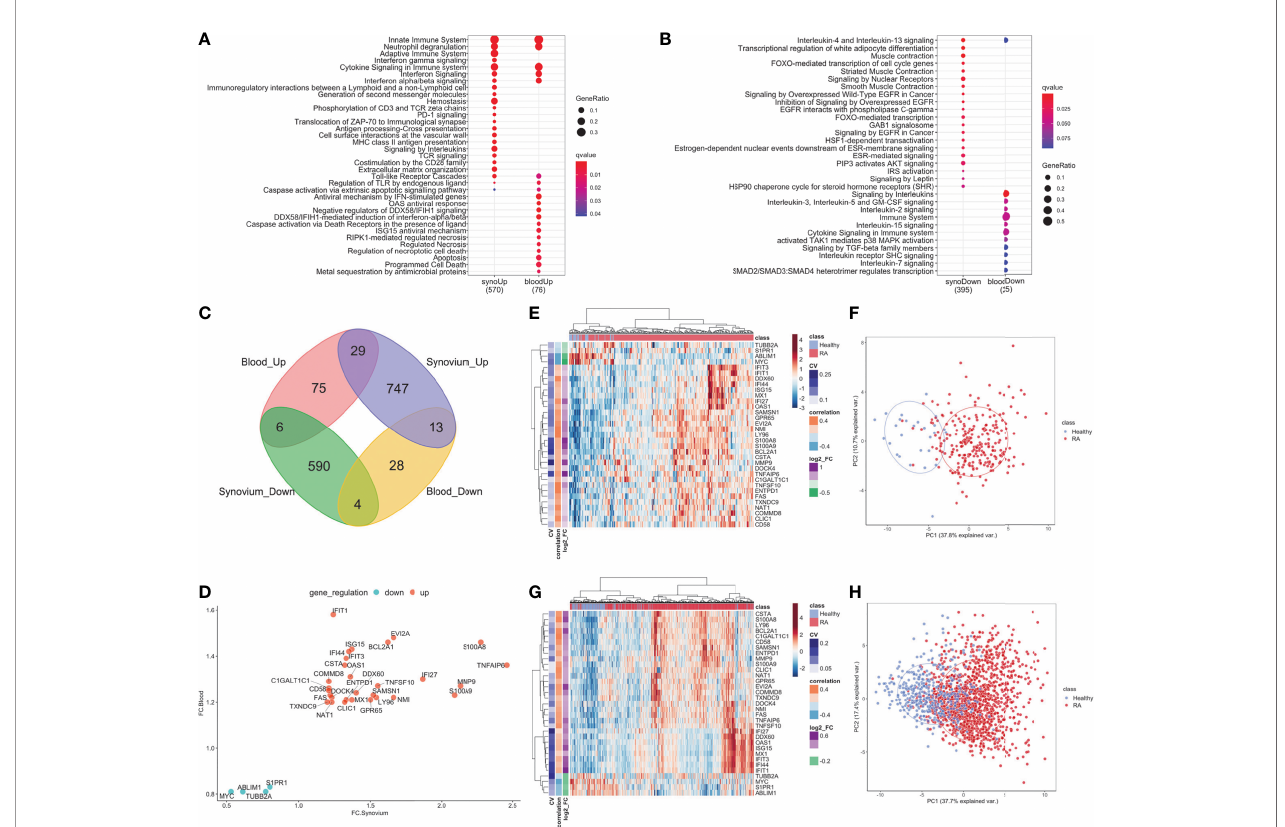
FIGURE 2 | DE genes overlapped between synovium and whole blood tissues. Top Reactome common and different pathways for (A) Up-regulated and (B) downregulated genes. (C) Venn diagram of up- and down-regulated genes in synovium and blood: 29 common up-regulated genes (p =3e-09) and 4 common downregulated genes (p = 0.28). (D) Comparison scatter plot of fold changes between common genes in synovium and blood. Heatmap and PCA plots of common genes in (E, F) synovium and (G, H) blood. Vertical bars in the heatmap plots represent the color-coded coef fi cients of variation, Pearson correlations and log2 fold